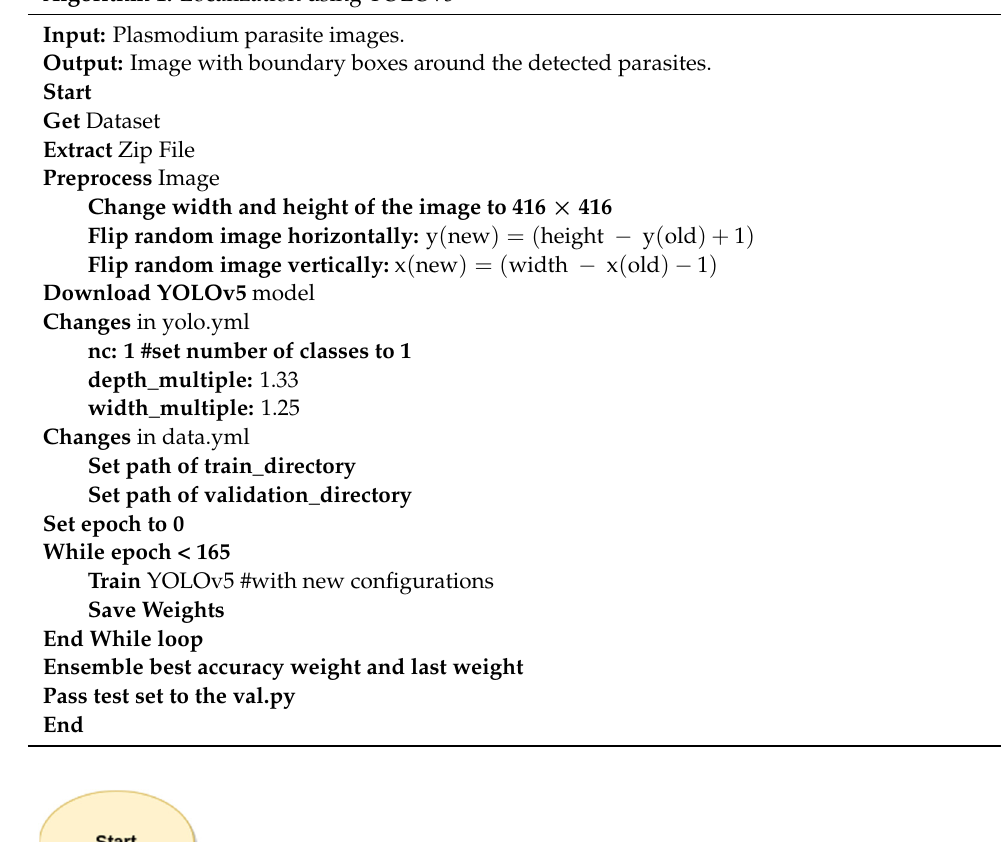
Algorithm 1: Localization using YOLOv5